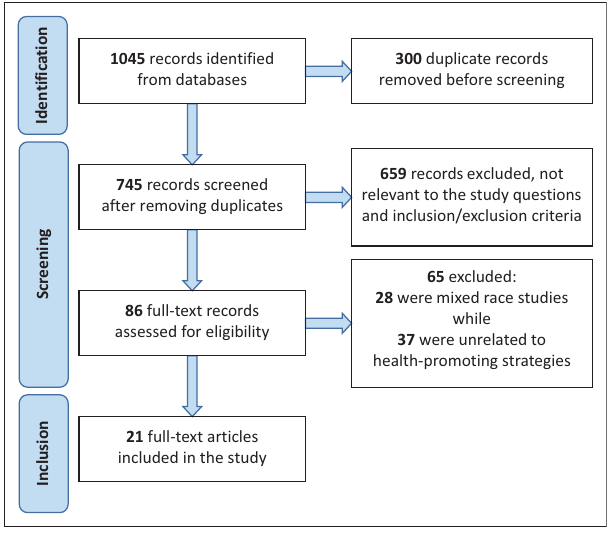
FIGURE 1: Flow diagram of article